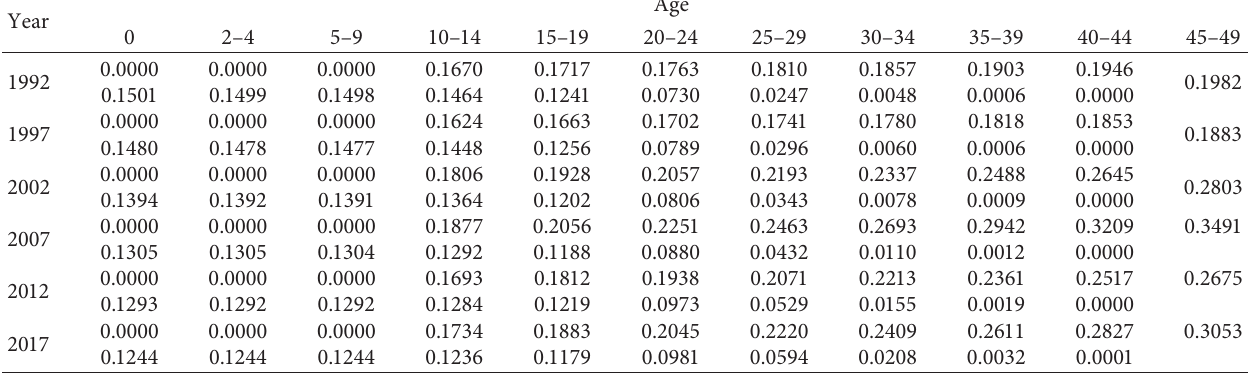
Table 3: Sensitivity matrices with the first row and subdiagonal elements (1992–2017).